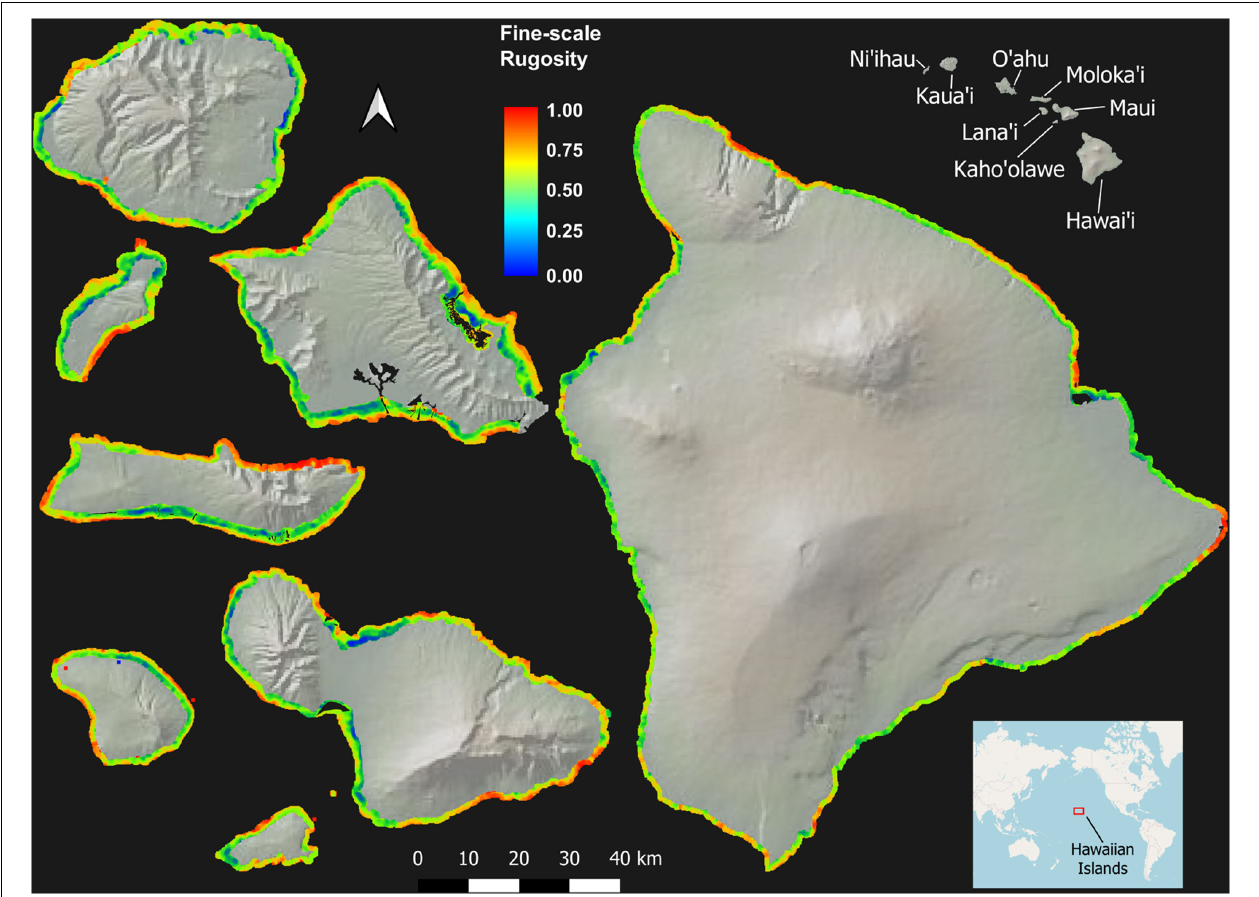
FIGURE 2 | Fine-scale rugosity of the eight Main Hawaiian Islands at 2 m spatial resolution to a depth of 22 m. Values are relative from 0.0 to 1.0. Coarse-scale rugosity is provided in Appendix Figure A1